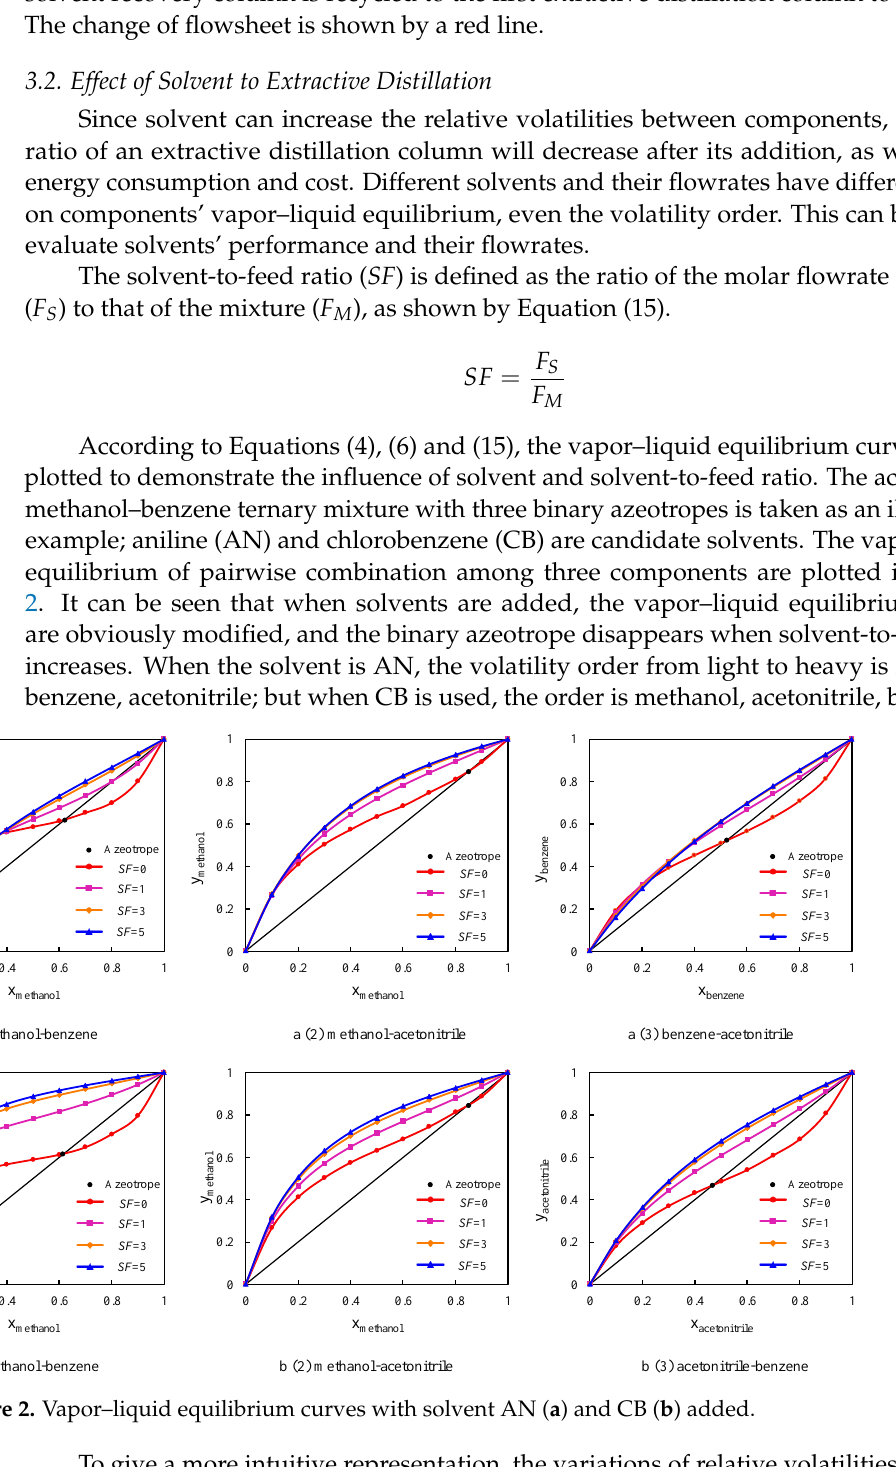
the mixture to be separated is 40% methanol, 30% benzene and 30% acetonitrile. As can be seen, with solvent AN, the relative volatility between benzene and acetonitrile increases slightly along the solvent-to-feed ratio, while that between methanol and benzene increases first and then decreases; with solvent CB, both relative volatilities increase